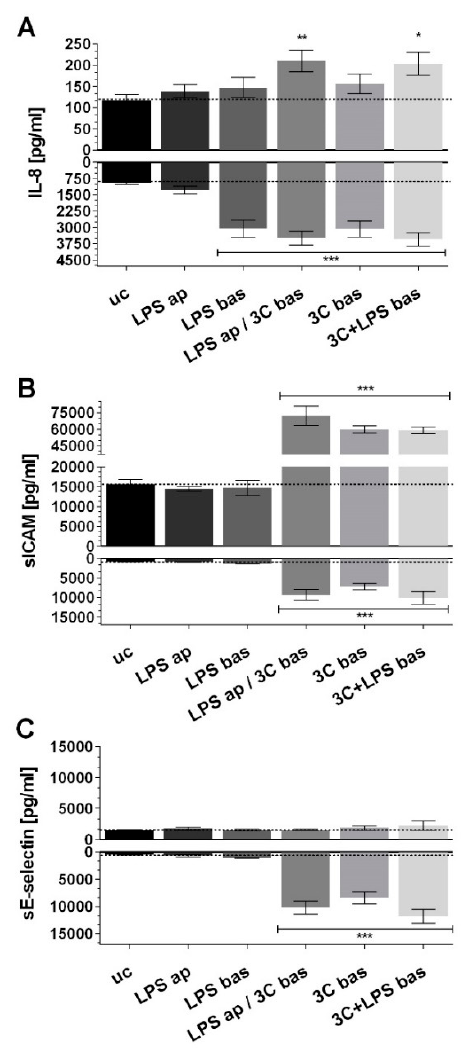
Figure 3. ELISA (enzyme linked immunosorbent assay) of ( A ) IL-8; ( B ) sICAM-1 and ( C ) sE-selectin (pg/mL) after stimulation of the coculture CC with different pro-inflammatory mediators for 48 h. ap: apical, stimulation in the upper well (Caco-2), bas: basolateral, stimulation in the lower well (ISO-HAS-1); LPS: lipopolysaccharide (1 µg/mL); 3C: cytokine mixture ((IL-1 β (100 U/mL), TNF- α (600 U/mL) and IFN- γ (200 U/mL)); release of inflammatory mediators in the upper (upward columns) compartment (apical) and lower (downward columns, basolateral); data are depicted as means ± SE of three independent experiments with n = 3. For statistical analysis one-way ANOVA with Dunnett’s Multiple Comparison test was conducted. * p < 0.05, ** p < 0.01, *** p < 0.001.